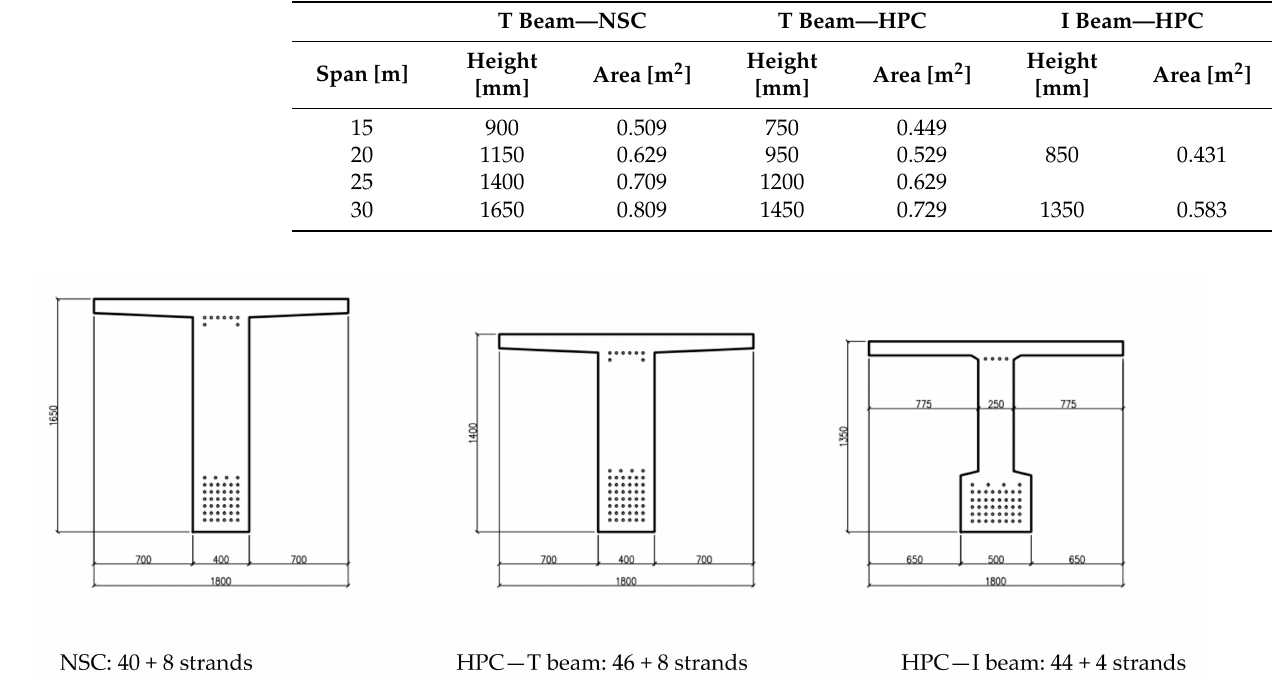
Table 8. Height of T beams designed for the study bridge.